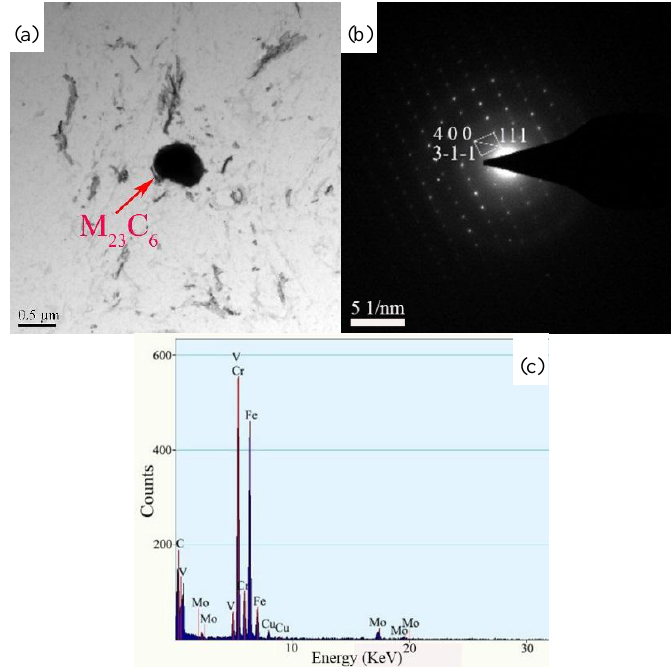
Figure 6. Precipitates of M 23 C 6 at the center of the H13 ingot after tempering: ( a ) Morphology by TEM; ( b ) SAED analysis; ( c ) EDS analysis.